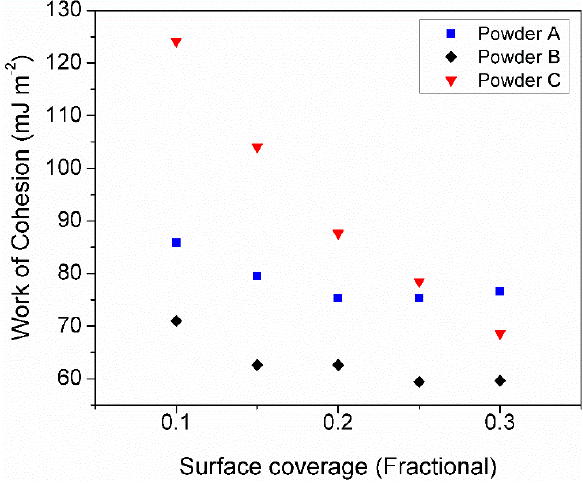
Figure 8. Comparison between the work of cohesion between powders A, B, and C.